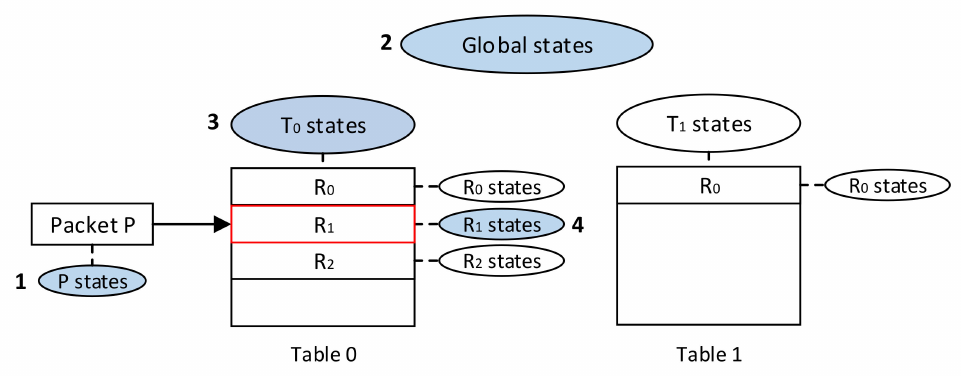
Figure 6. Four state areas that can be accessed when the packet, P , matches the entry R 1 in the table T